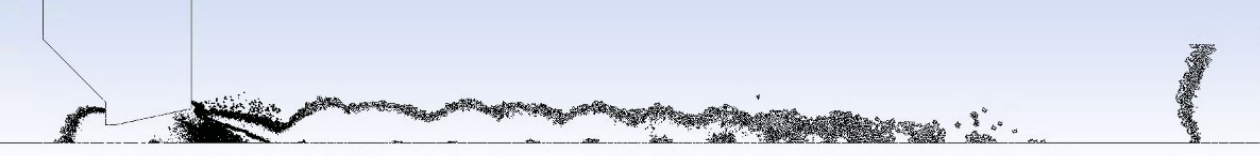
Figure 14. Detailed view of the nozzle area with a distinctly fine mesh. Multiple manual adaptive refinements were performed according to the pressure gradient during the calculation. This resulted in refinement in the regions of the shock waves, shown further down. Figures 15 and 16 show a close-up view of the first shock wave region shortly after the nozzle.